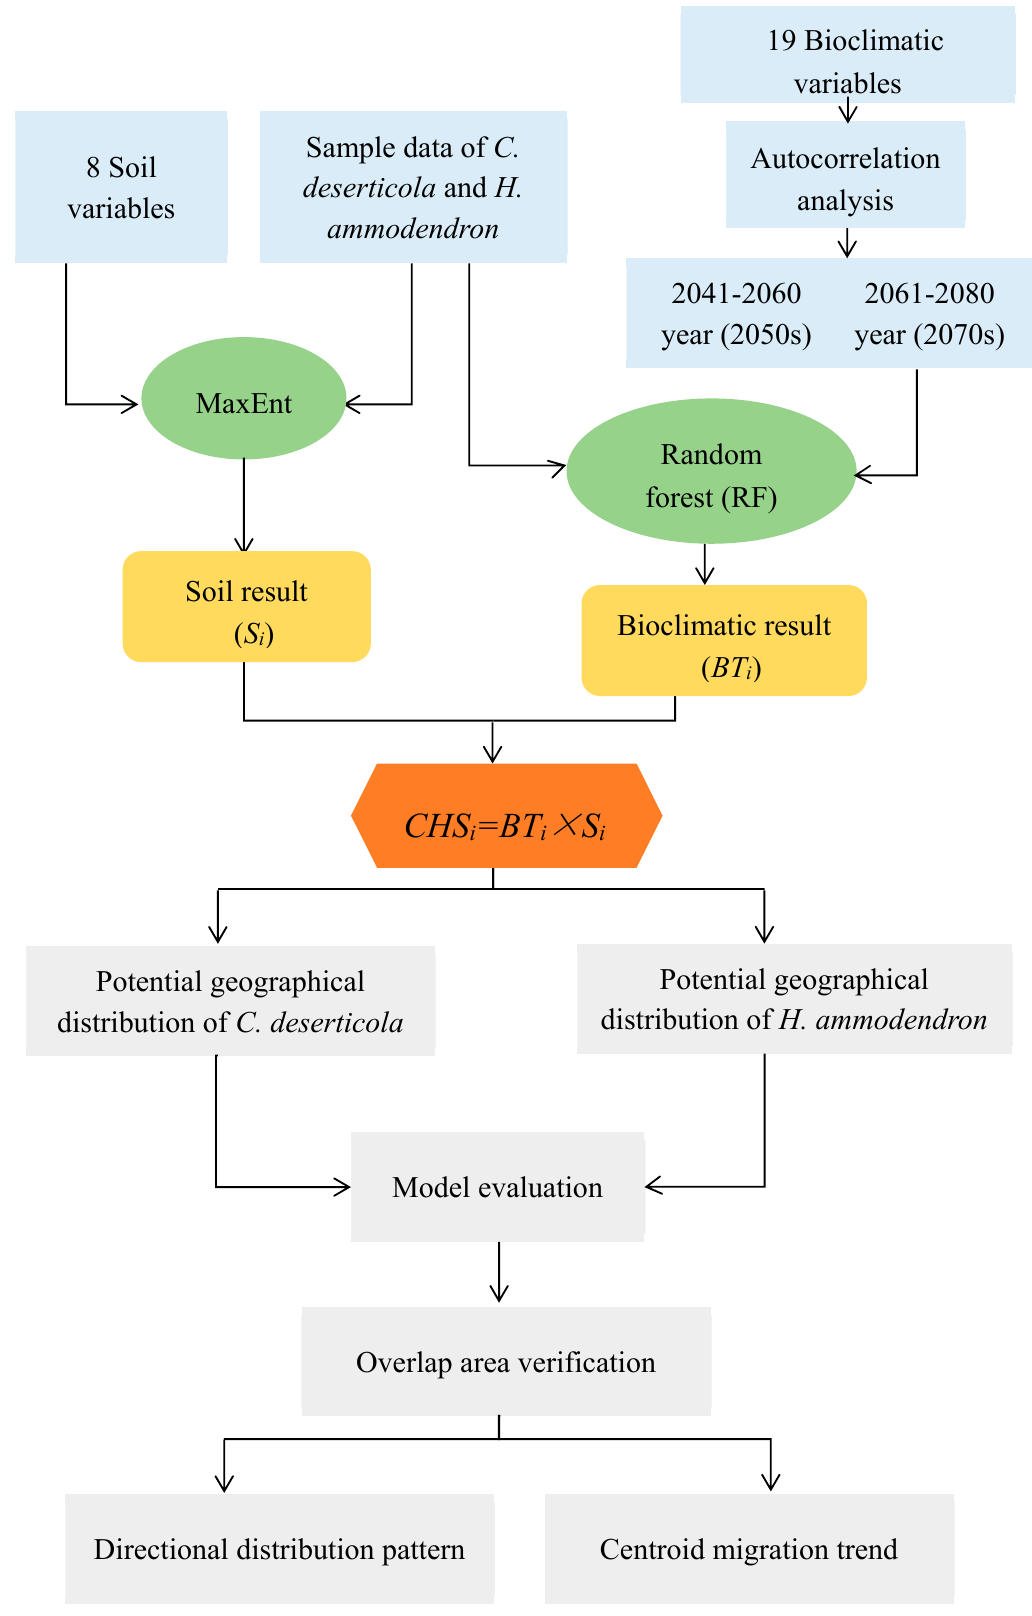
Figure 1. Methodological approaches of comprehensive habitat suitability evaluation.